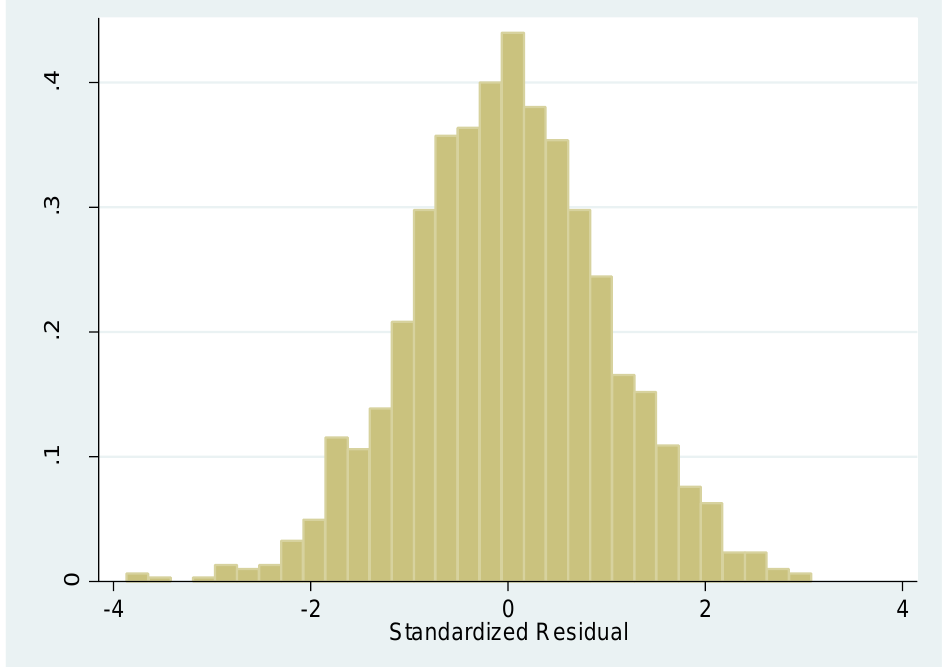
Figure A1. Histogram of the Standardized Residual from the Model for Annual Total Health Care Expenditure. Model: MLE assuming Normal distribution with